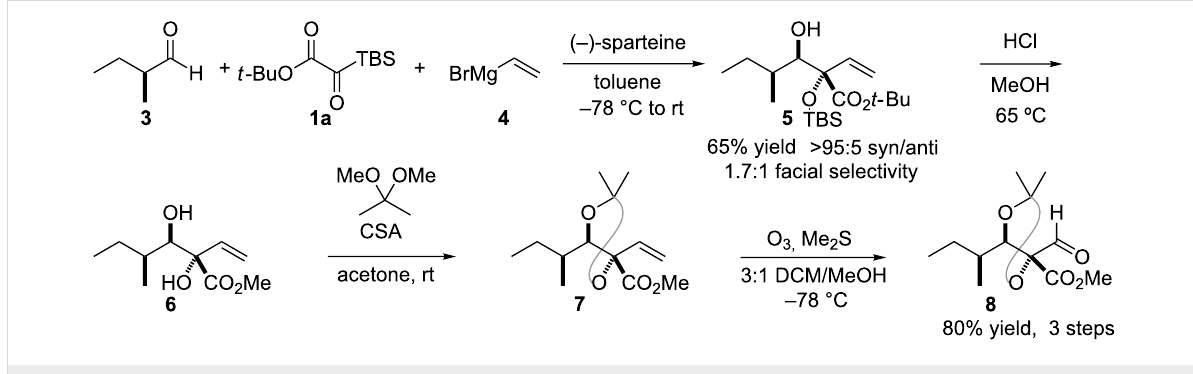
steps, in high overall yield. Simultaneous cleavage of the silyl ether and transesterification from the tert -butyl to the methyl ester in 6 was effected by warming in acidic methanol.